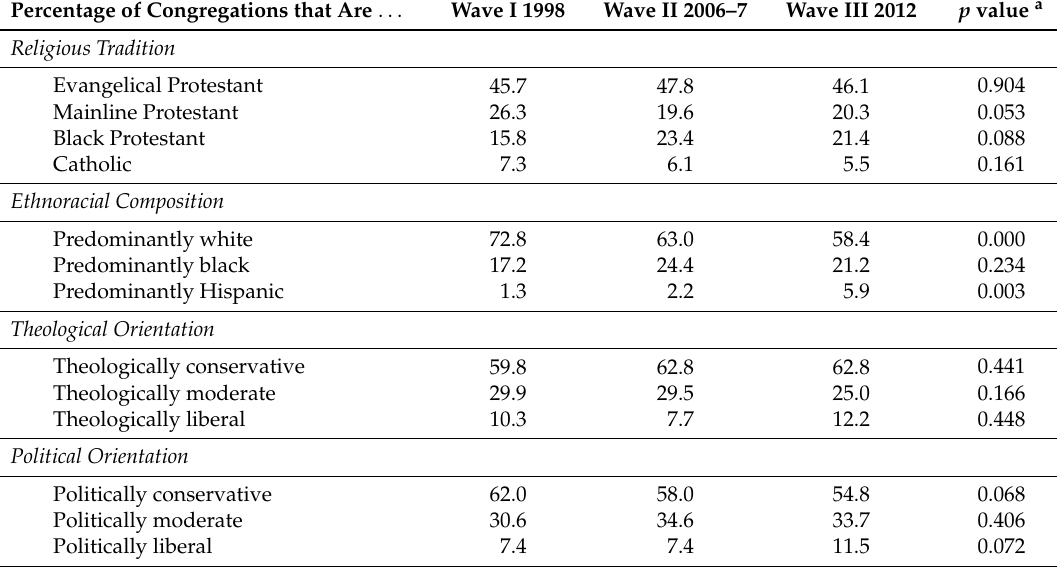
Table 2. The percentage of congregations by religious tradition, ethnoracial composition, and ideological orientation for each wave. Percentage of Congregations that Are . .